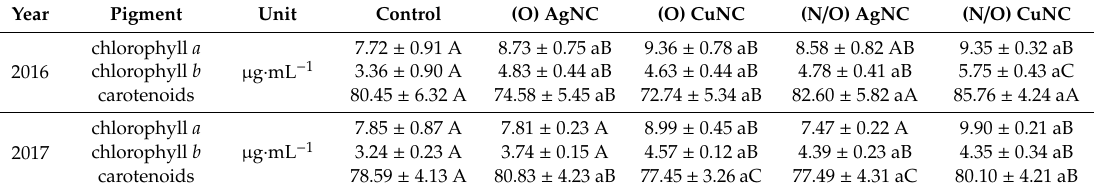
Figure 1. Micrographs of ( A ) AgNC and ( B ) CuNC on the right, magnified 100,000 × . Table 1. Chlorophyll and carotenoid content in virgin rapeseed